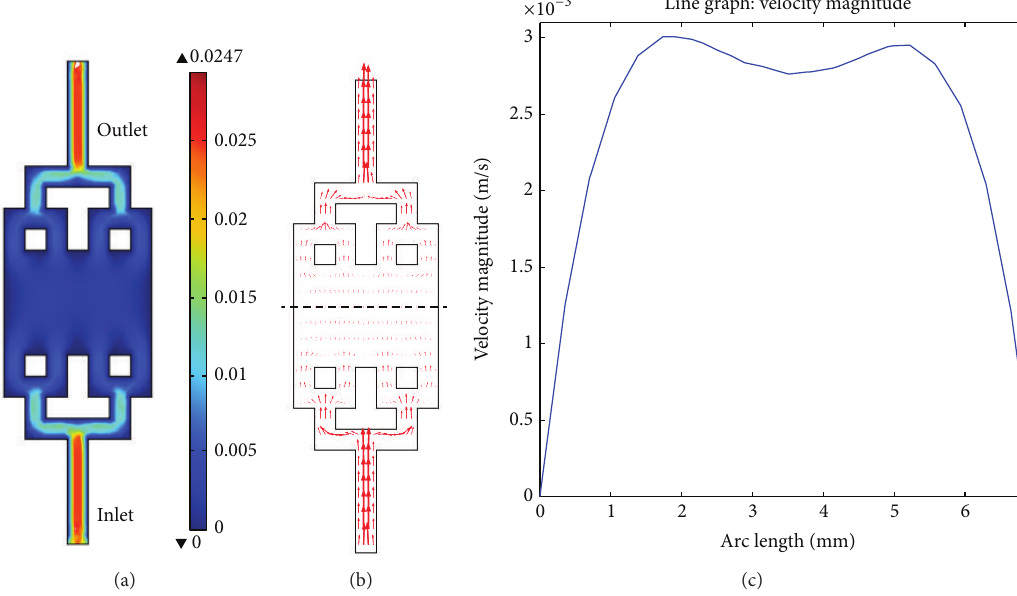
Figure 4: Fluid flow analysis of (a) velocity field surface plot. The colour spectrum bar shows the velocity field generated in the fluid system; (b) surface arrow plot and (c) the average velocity across the length of the middle microfluidic channel (represented by dashed line).